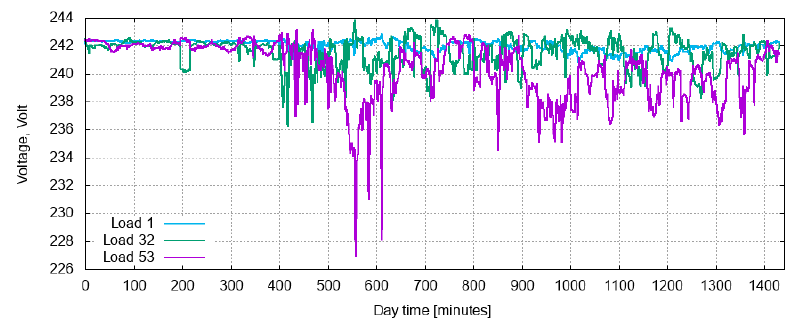
Figure 2. Time series solution on the absence of attack—normal circumstances.